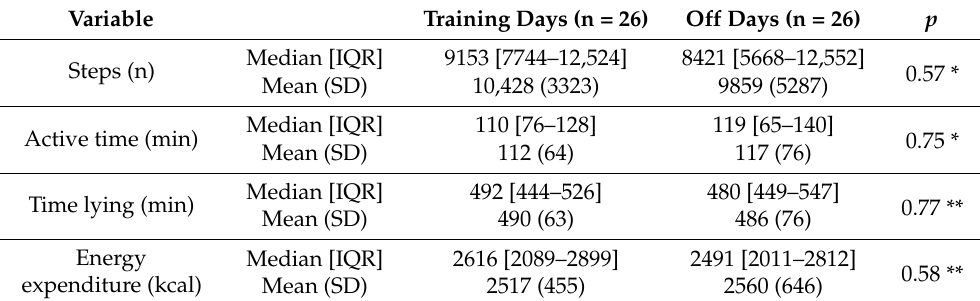
Table 2. Results of the study.